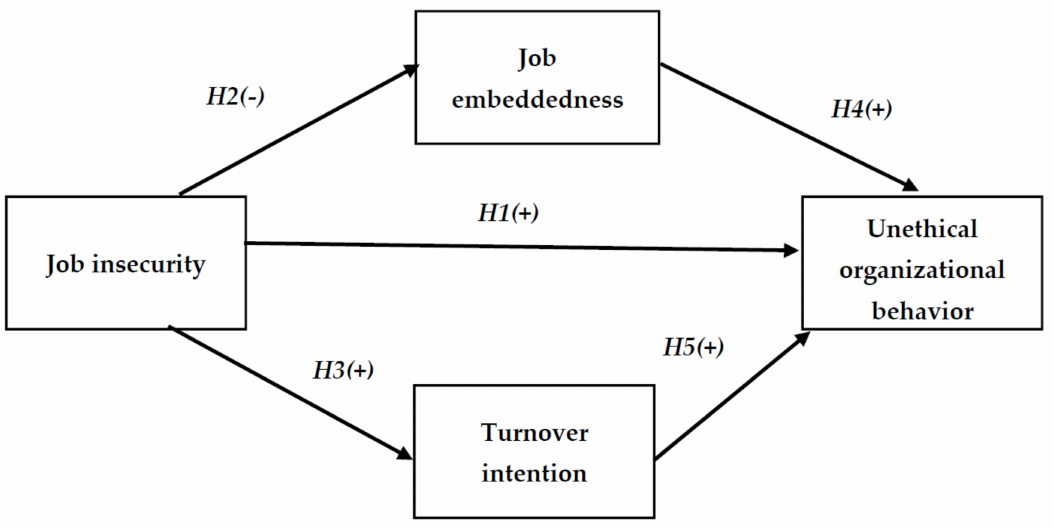
Figure 1. A research framework (developed by